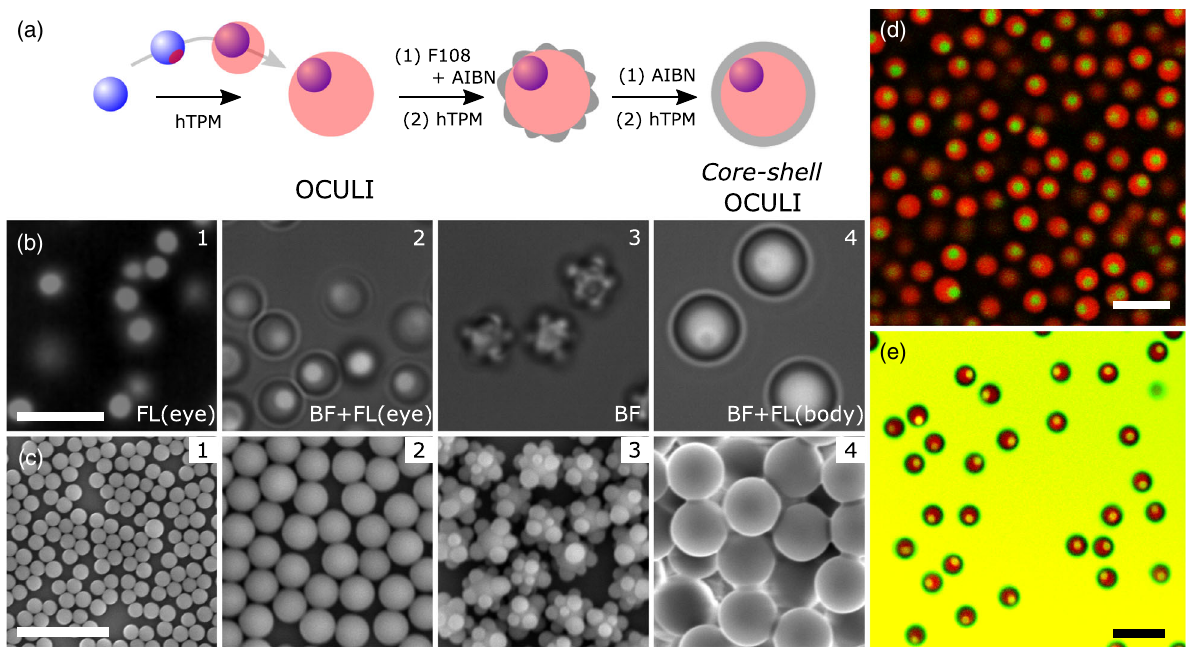
FIG. 1. Synthesis of OCULI and core-shell OCULI particles. (a) Schematic of how monodisperse TPM particles are embedded in prehydrolyzed TPM (hTPM) to form off-centered OCULI particles. Further coating by hTPM in a two-step procedure via intermediate raspberry particles results in “ core-shell OCULI ” particles. (b1) Fluorescence image of TPM “ eye ” particles. (b2) OCULI particles, imaged in bright field with fluorescence excitation of the eye. (b3) Raspberry OCULI particles, imaged in bright field. (b4) Core-shell OCULI particles, imaged in bright field with fluorescence excitation of the OCULI body. (c) SEM pictures of particles in (b). (d) Two- channel confocal microscopy image of OCULI particles. (e) Two-channel confocal microscopy image of core-shell OCULI particles. The solvent is also dyed with a trace amount of BDP-FL. All scale bars are 5 μ